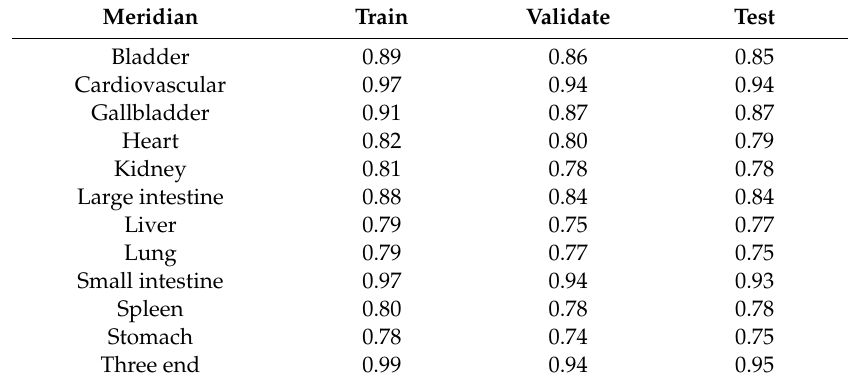
Table 2. The performance of ROC-AUC in training, validation, and test datasets among 12 Meridians.